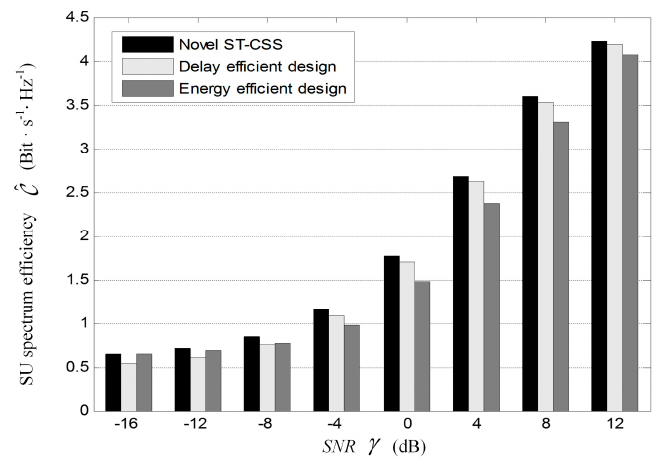
Figure 11. Comparisons of SU spectral efficiency among the schemes of the proposed ST-CSS, the transmission delay efficient design and the energy efficient design.